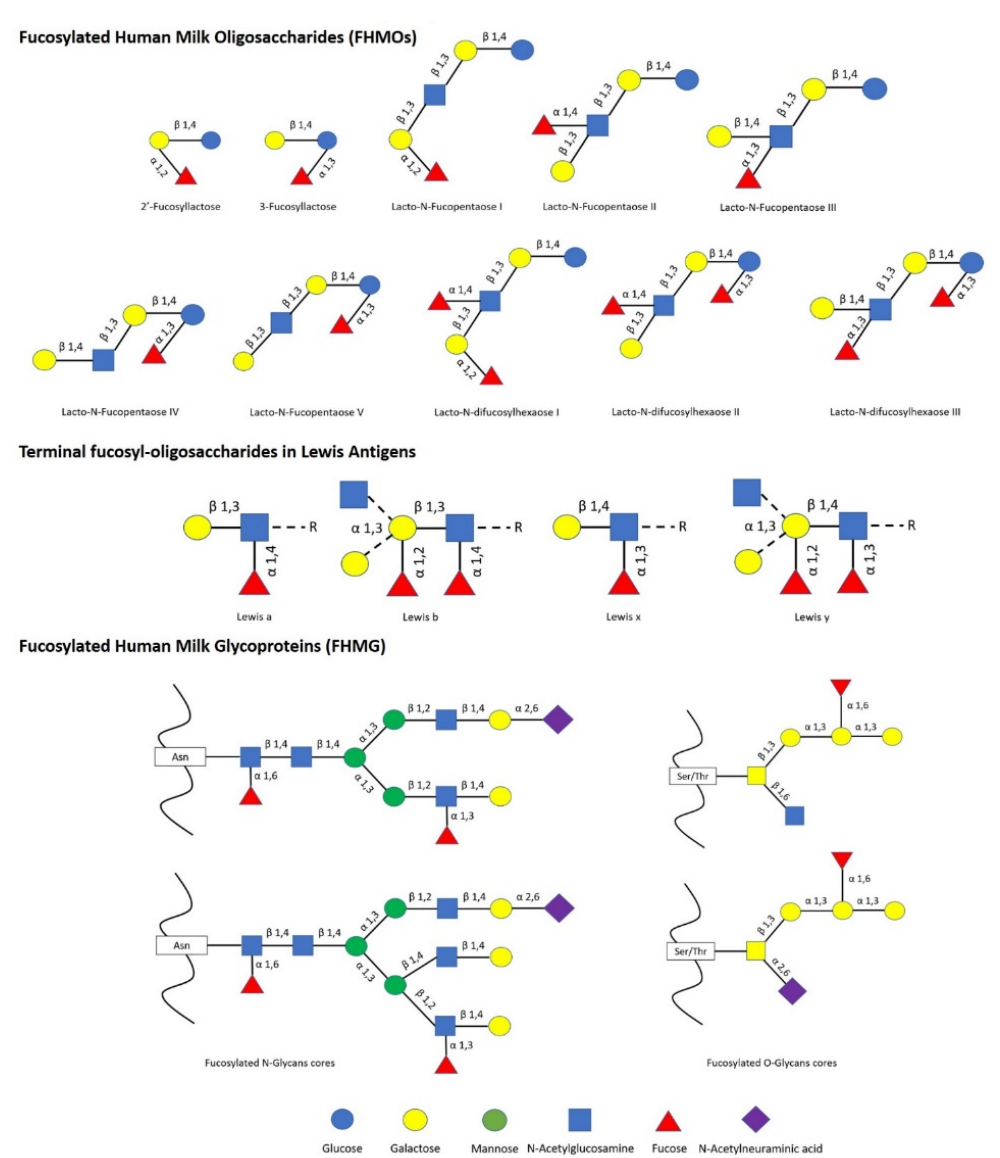
Figure 1. List of main fucosylated human milk oligosaccharides (FHMOs) and fucosylated human milk glycoproteins (FHMG) reported [1,6,7].